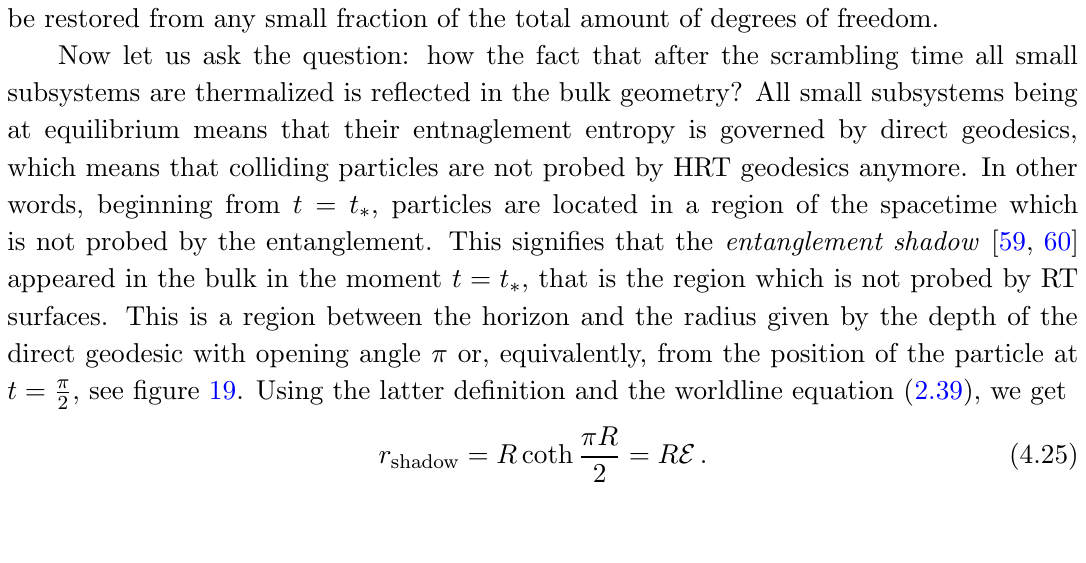
Figure 19 . The grey region is the entanglement shadow, which appears when t > (cid:25) curve is the maximal RT